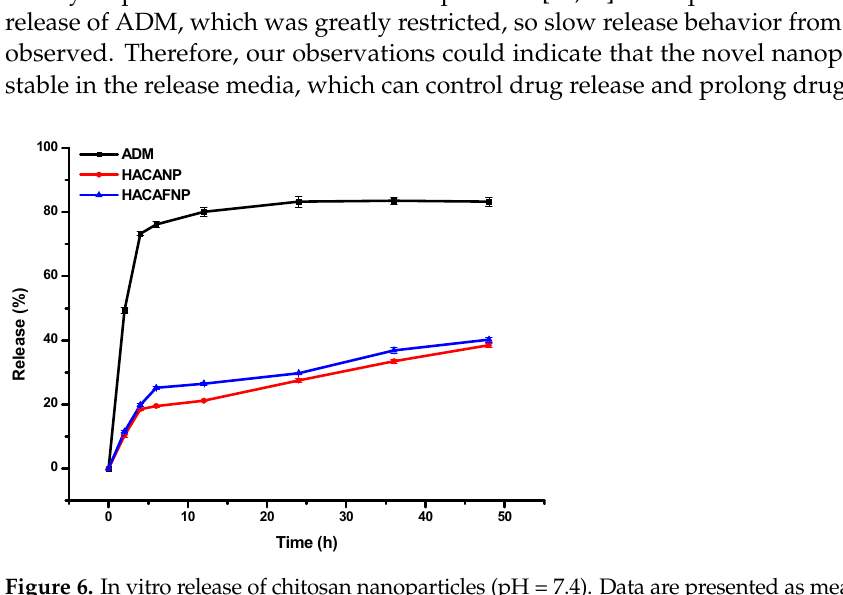
Figure 6. In vitro release of chitosan nanoparticles (pH = 7.4). Data are presented as mean value ±